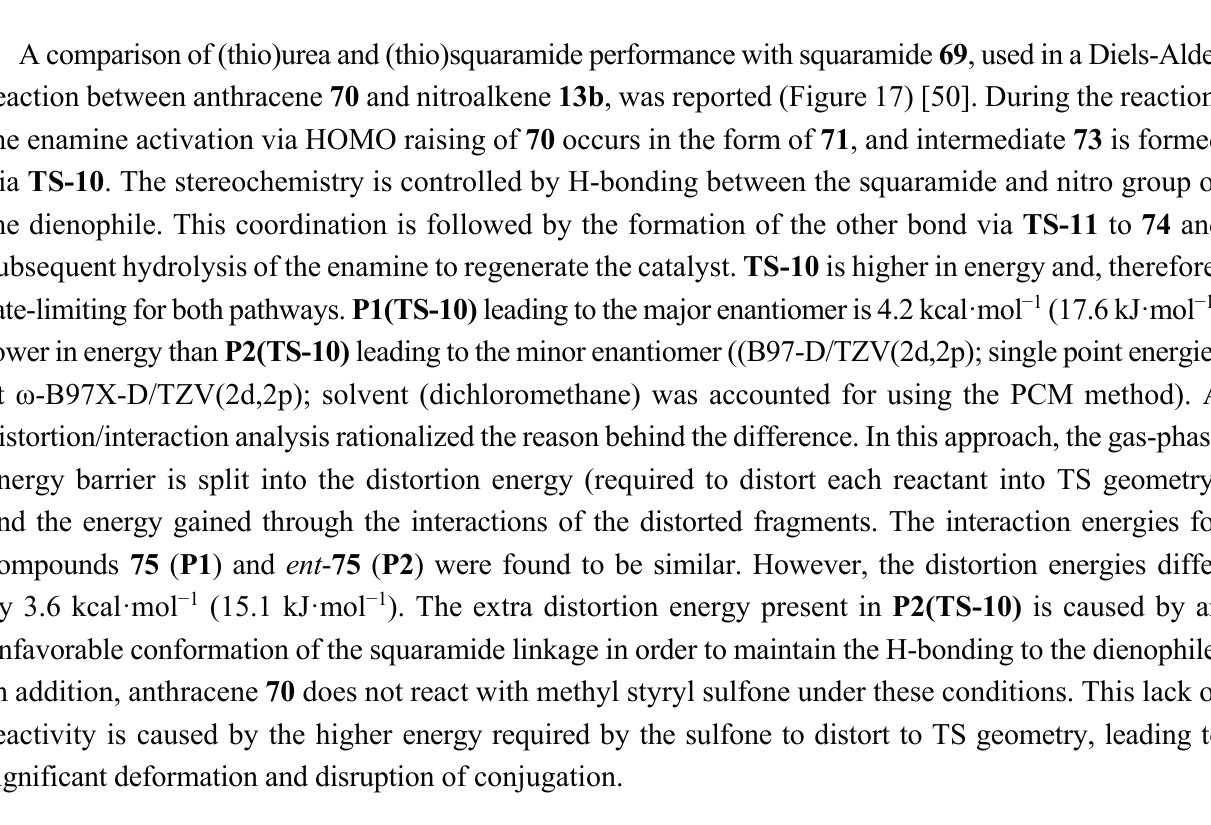
Figure 16. Michael addition of β -ketoamides 64 to α , β -unsaturated carbonyl compound 17 , catalyzed by 4 ( a ); calculated transition states ( b